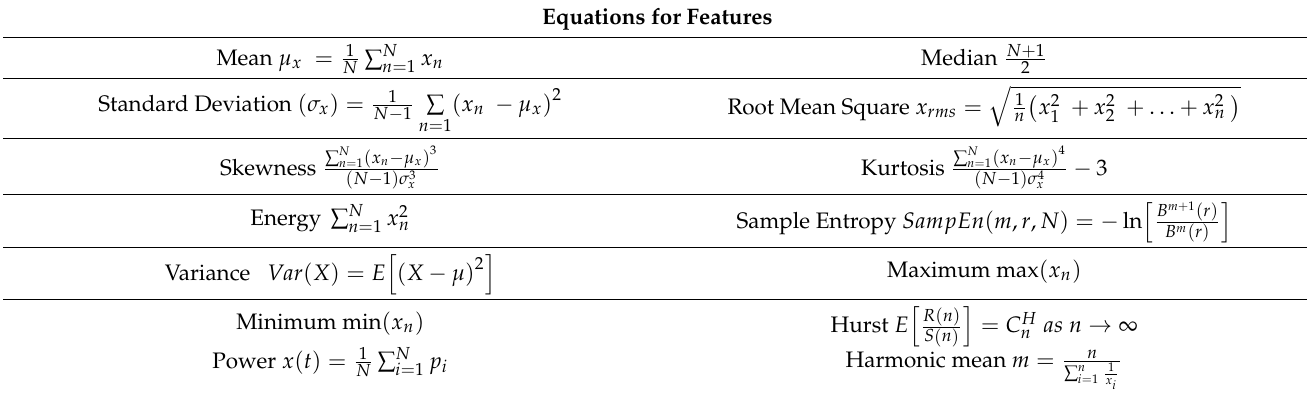
Table 1. EOG features and its equations. Equations for Features